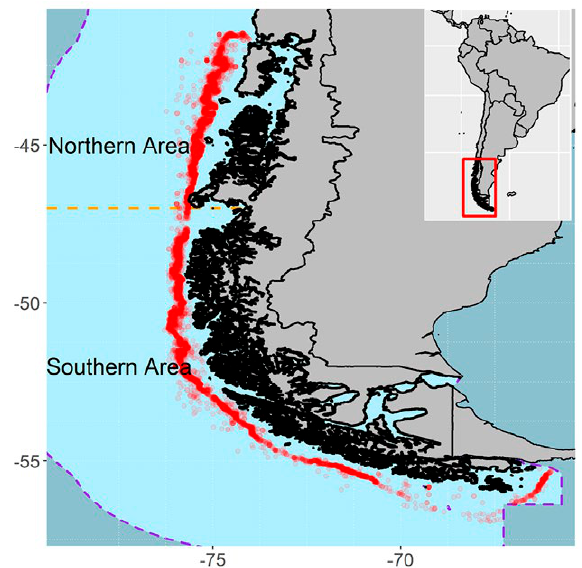
Fig. 1. – Map of the study area indicating the fishing areas. Red dots are the hauls with presence of pink cusk-eel in longline industrial fishery.